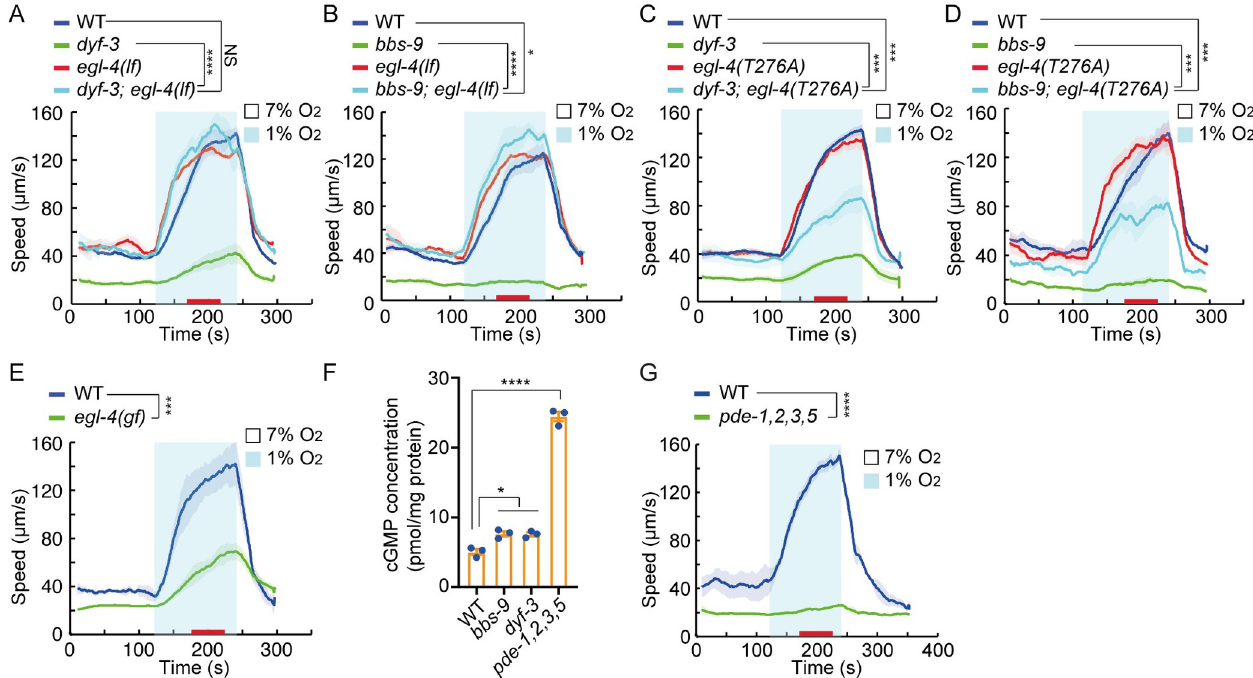
Fig 2. High EGL-4/PKG activity inhibits the acute hypoxia response. (A–E) Locomotory responses to 7% to 1% O 2 stimuli for animals of the indicated genotypes: WT, dyf-3(m185) , egl-4(n478) , and dyf-3(m185) ; egl-4(n478) double mutants (A); WT, bbs-9(gk471) , egl-4(n478) , and bbs-9(gk471) ; egl-4(n478) double mutants (B); WT, dyf-3(m185) , egl-4(T276A) , and dyf-3(m185) ; egl-4(T276A) double mutants (C); WT, bbs-9(gk471) , egl-4(T276A) , and bbs-9(gk471) ; egl-4(T276A) double mutants (D). T276A in C and D stands for a threonine to alanine substitution at residue 276, which disrupts the low cGMP binding site of EGL-4. WT and egl-4(ad450) (E); egl-4(ad450) is a gain-of-function allele of egl-4 . ���� = p < 0.0001, ��� = p < 0.001, � = p < 0.05, NS = not significant. ANOVA, Tukey multiple comparison (A–D), and Mann–Whitney U test (E). (F) Total cGMP levels in animal lysates of indicated genotype measured by a cGMP enzyme immunoassay ( n = 3). Error bars = SEM. � = p < 0 . 05 , ���� = p < 0.0001. ANOVA, Tukey multiple comparison. (G) Locomotory responses to 7% to 1% O 2 stimuli for animals of the indicated genotype: WT and pde-1(nj57); pde-2(tm3098); pde-3(nj59); pde-5(nj49) quadruple mutants ( pde-1 , 2 , 3 , 5 ). ���� = p < 0.0001, Mann–Whitney U test. The underlying data can be found in S1 Data, and the source code can be found at https://github.com/wormtracker/ zentracker. O 2 , oxygen; WT, wild-type.